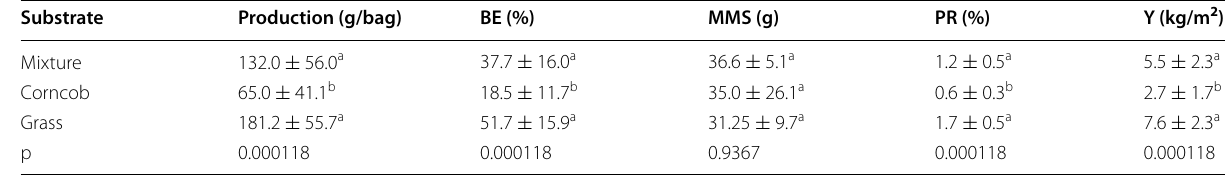
Same letter in the same column indicates no statistical difference between substrates (alpha BE biological efficiency, MMS mean mushroom size (g), PR production rate (%), Y